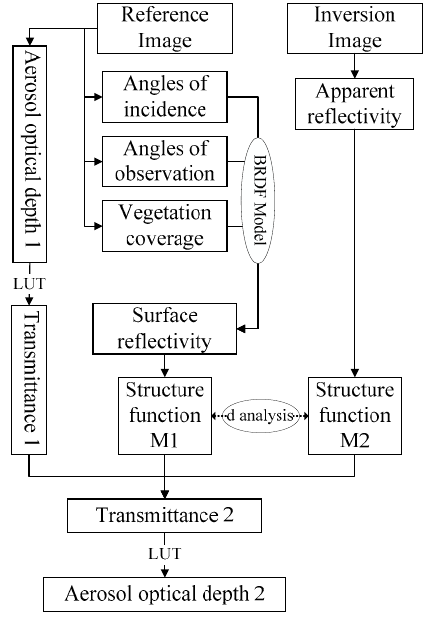
Figure 5. Flow chart of aerosol optical depth inversion based on structure function.